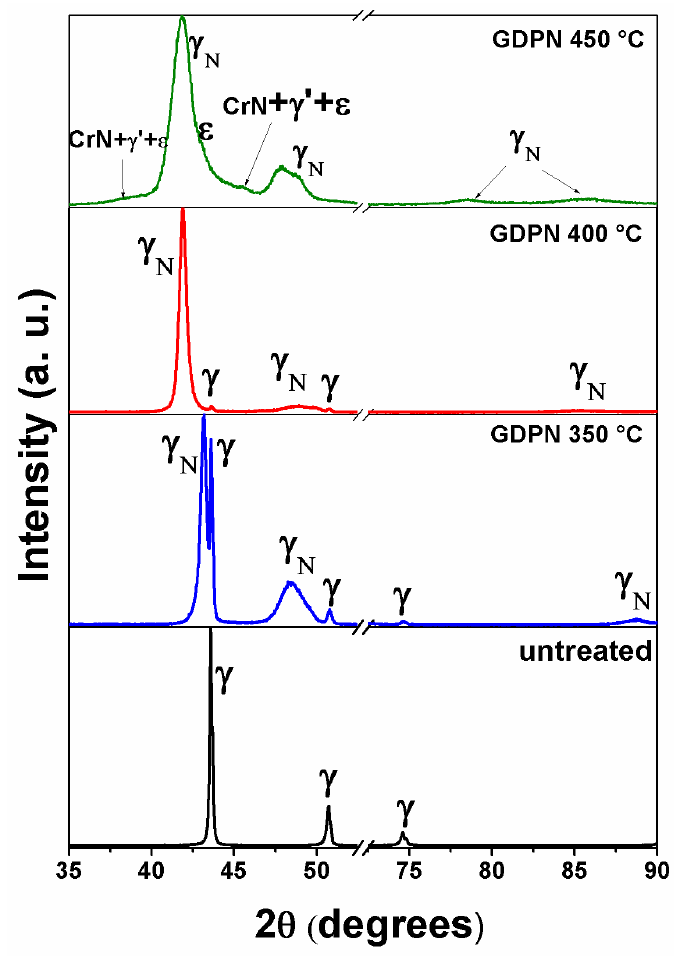
Figure 6. X-ray diffractograms for samples untreated and nitrided by GDPN AISI 316 steel at different temperatures.